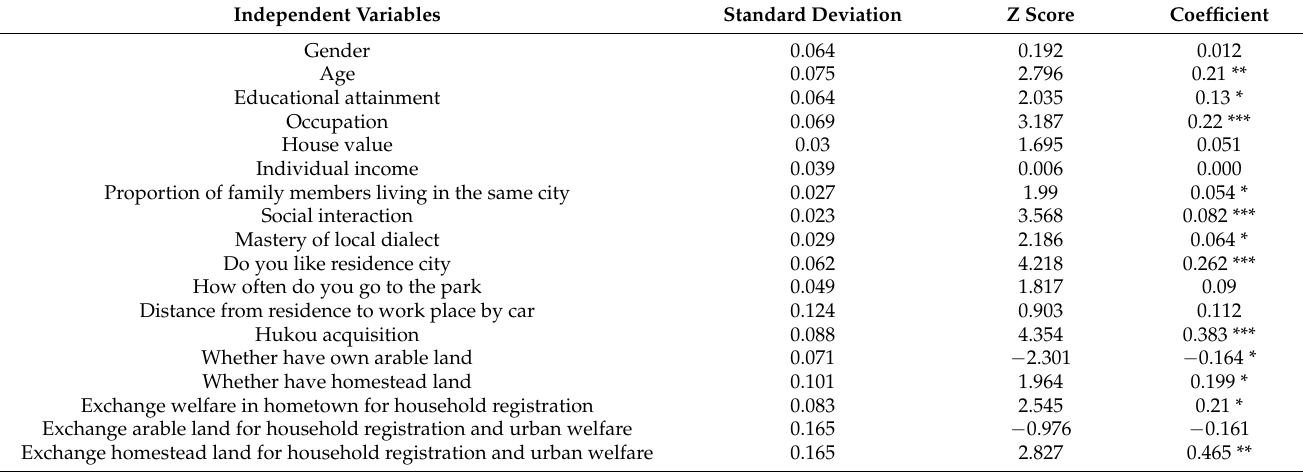
Table 7. Probit regression analysis of reasons underlying migrants’ settlement intentions (model